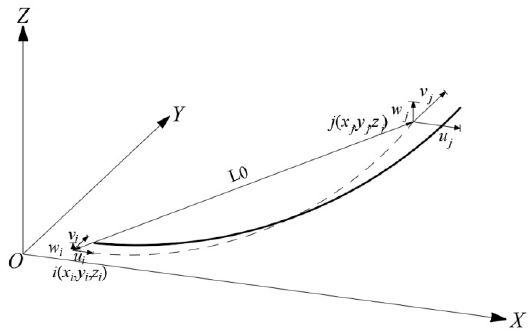
Figure 1. The general coordinate system of cable element.